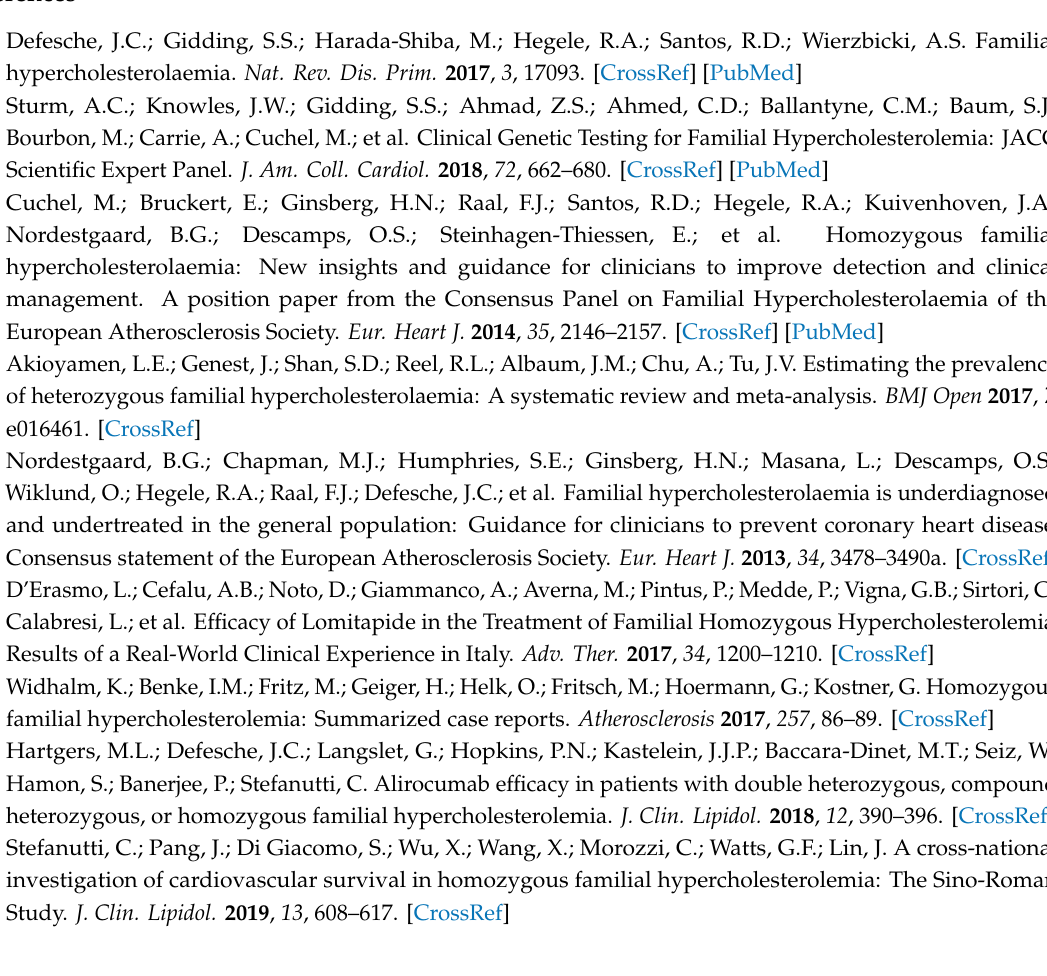
Table S1: Primers used for direct sequencing of LDLR